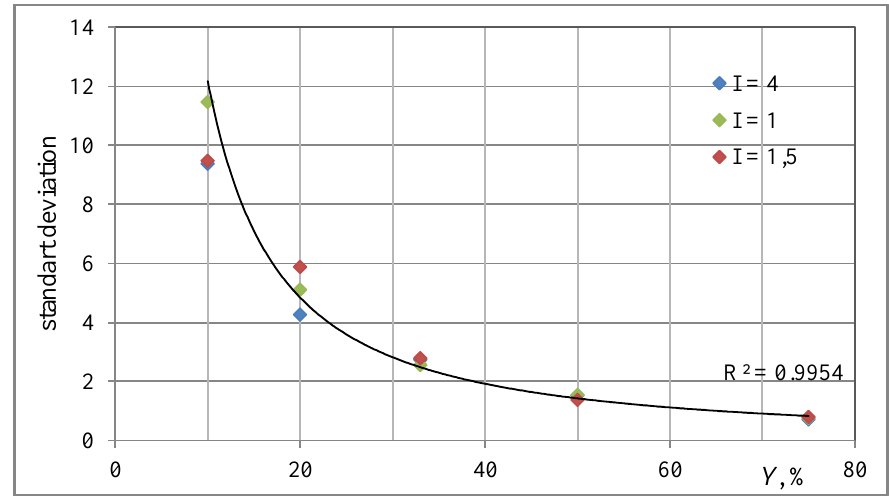
Figure 5. Dependence of MSD of the number of negotiations upon the concession 𝑌 at different power in- dices of coalitions